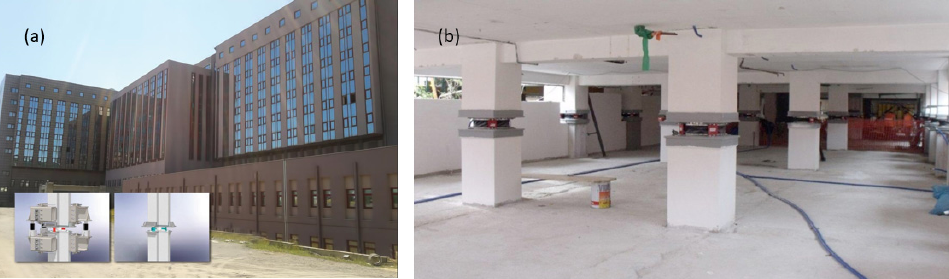
Figure 35. ( a ) Marmara University Prof. Dr. Asaf Ataseven Hospital and retrofitting procedure ( b ) Isolation floor of the hospital (Courtesy of Freysa ş ).